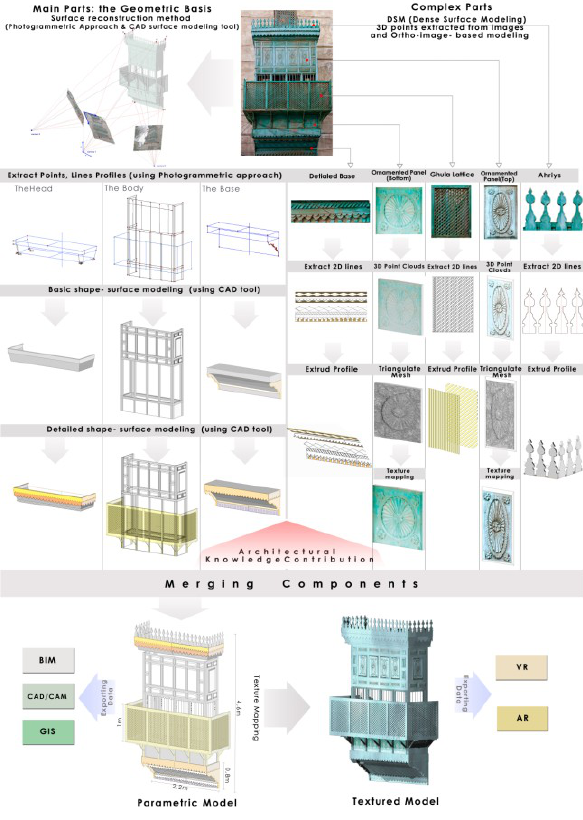
Figure 4. Schematic diagram of surveying and modelling